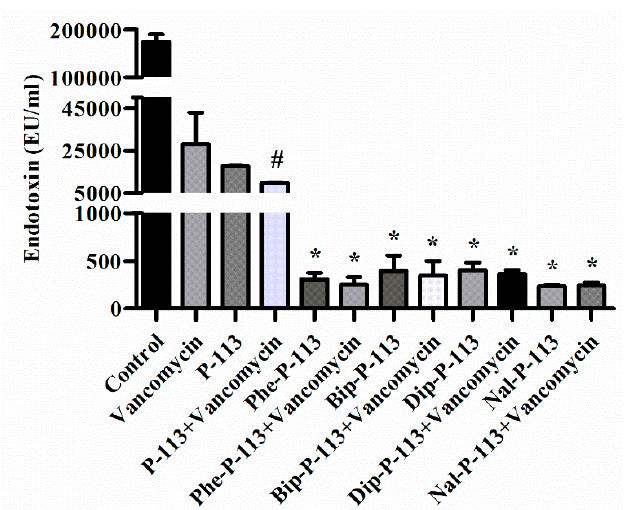
Figure 5. The influence of vancomycin, P-113 and its derivatives on LPS release from E. coli . E. coli ATCC 25922 were incubated at the mid-log phase (10 4 CFU / mL) and treated with peptide alone (at 1 × MIC) or combination with vancomycin (both at 0.5 × MIC) at 37 ◦ C for 6 h. The samples were filtered through 0.2 µ m pore filter and the endotoxin level was detected by LAL assay. # p < 0.05 compared with vancomycin only, * p < 0.001 compared with vancomycin only. The experiments were performed in triplicate.